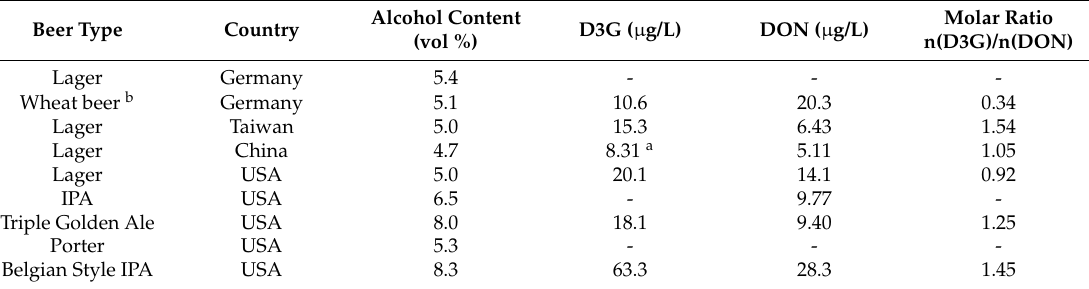
Table 3. Contents of D3G and DON in the analyzed beer